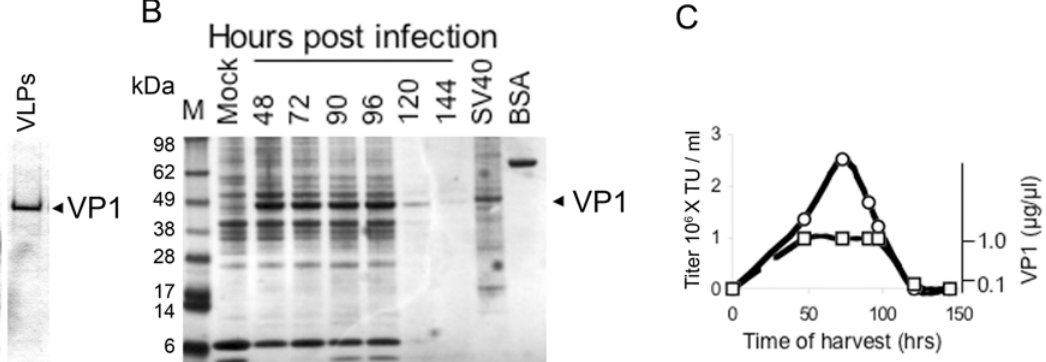
Figure 2. The reaction requires cellular factors. A–VLPs were purified on sucrose gradient from nuclear extracts harvested on day 3. M-molecular weight marker; VLPs–purified VLPs used in the packaging experiment (Table 1). B-Nuclear extracts were harvested from infected Sf9 cells at different time points after infection, as designated on top, and analyzed by SDS-PAGE and Coomassie-blue staining. M-molecular weight marker; Mock-nuclear extract of Sf9 cells infected with wild type baculovirus; SV40-nuclear extract of CV1 cells infected with wild type SV40; BSA-1 m g BSA, a standard for band intensity. C-Activity of the nuclear extracts shown in part B. # -Packaging activity measured as titer (left ordinate); % -VP1 level estimated from A (right ordinate).